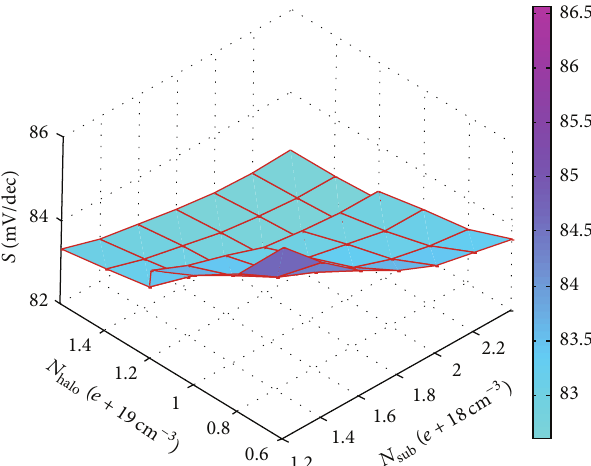
Figure9:Draincurrentasafunctionofchanneldopingfordifferent halo doping.